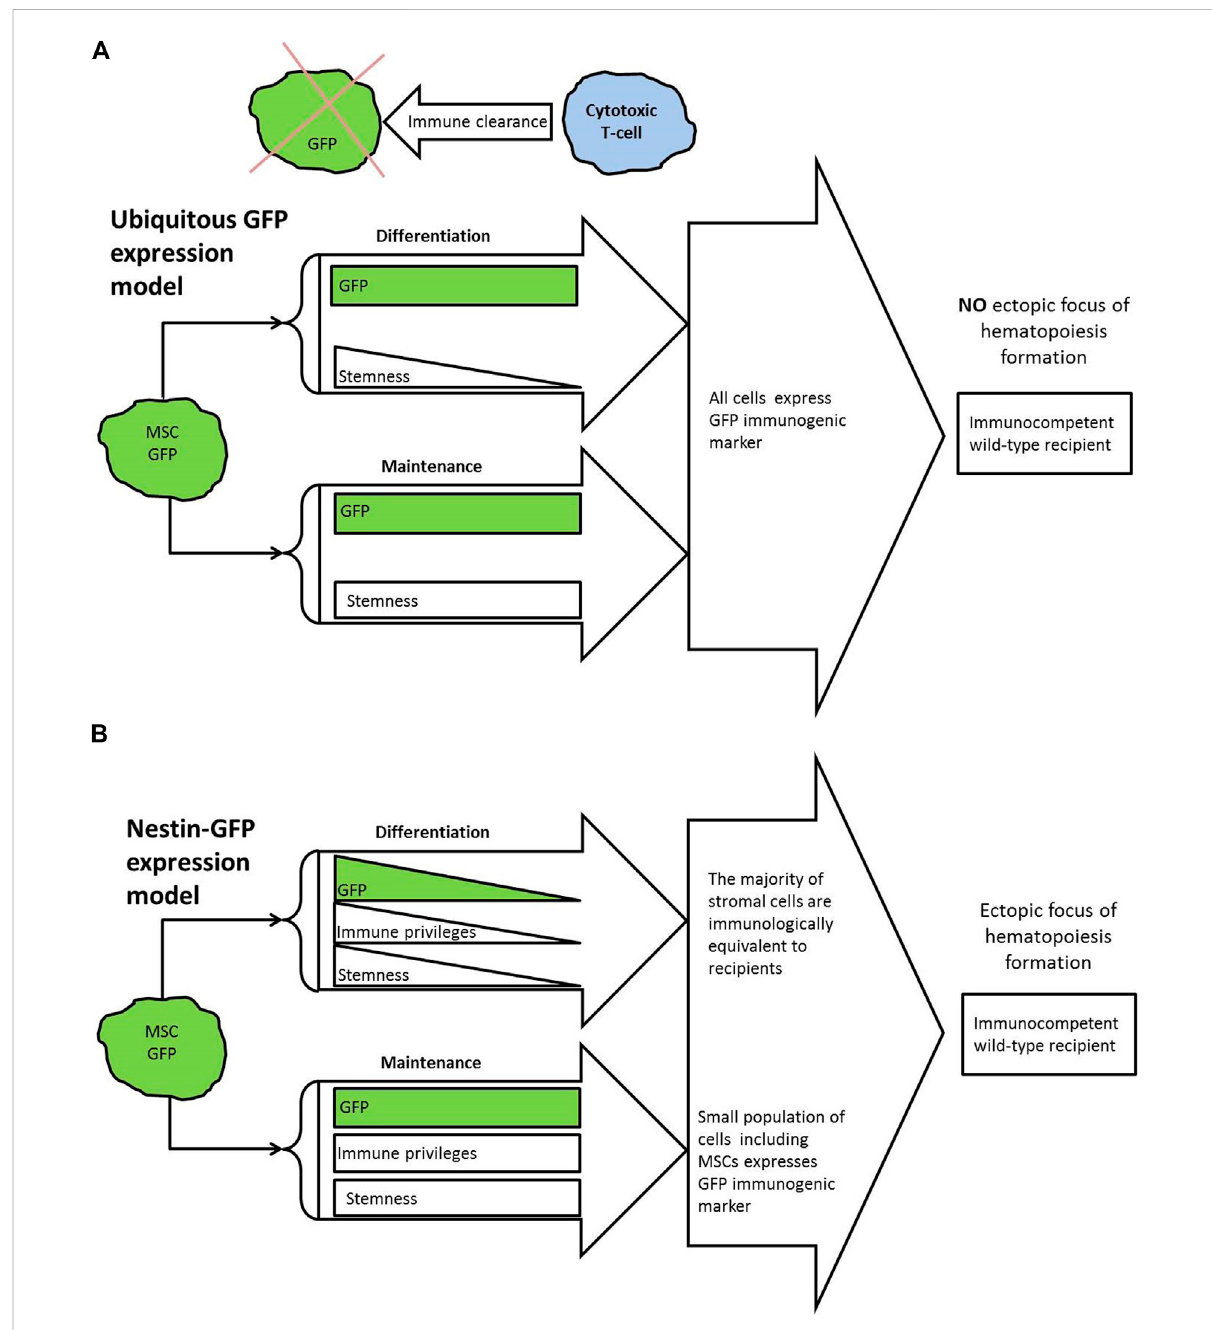
FIGURE 1 (A) Summary of knowledge and theoretical model. GFP is known to activate cytotoxic T-cells in wild-type recipients that results in immune clearanceofGFP-markedtransplants.Bonemarrowstromaisknowntobenotimmuneprivilegedingeneral.So,ifallimplantedstromalcellsexpress GFP, this should not lead to the formation of ectopic foci with GFP + cells in immunocompetent wild-type recipient. (B) Overview of presented experimental model. For used Nes-GFP strain, GFP expression was demonstrated in bone marrow MSCs. GFP expression known to fade in course of differentiation. According to presented results, small part of GFP-producing cells and particularly MSCs are capable to survive in immunocompetent mice of wild-type for 6 weeks and keep their functionality. In this case GFP does not interfere with focus